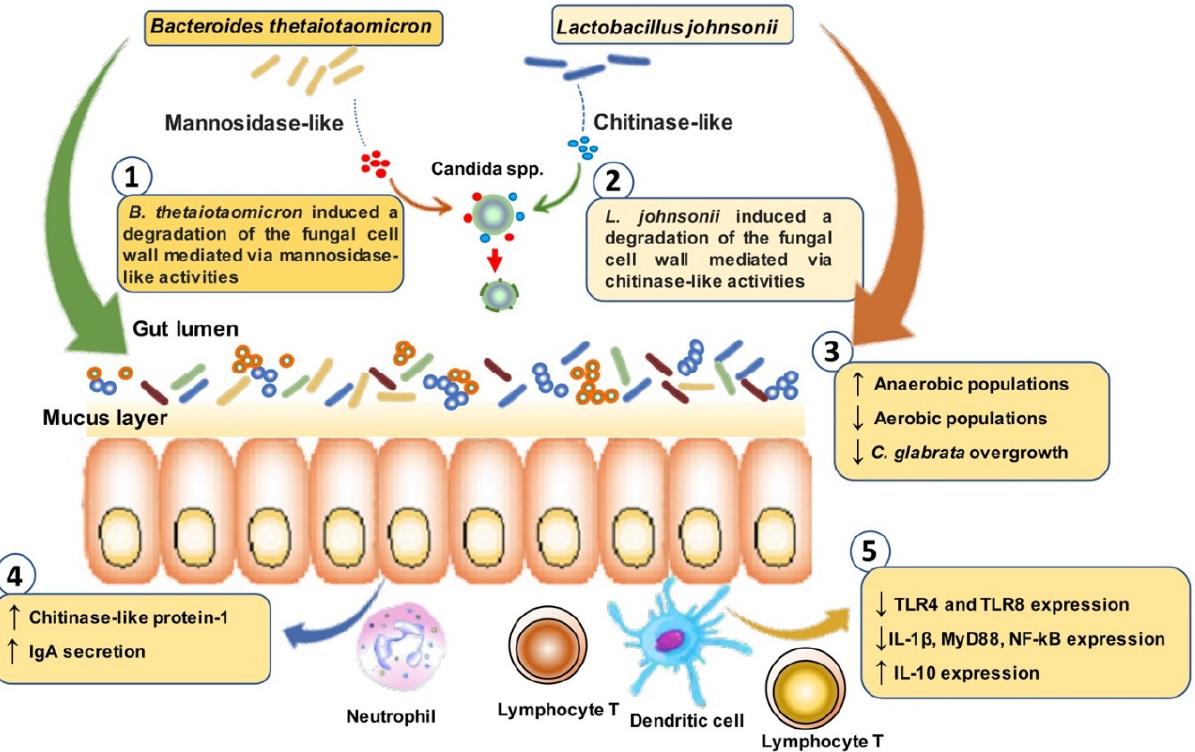
Figure 5. L. johnsonii and B. thetaiotaomicron decreased intestinal inflammation mediated by modu- lation of TLR expression and promoted the elimination of C. glabrata from the gut via chitinase-like and mannosidase-like activities [79].